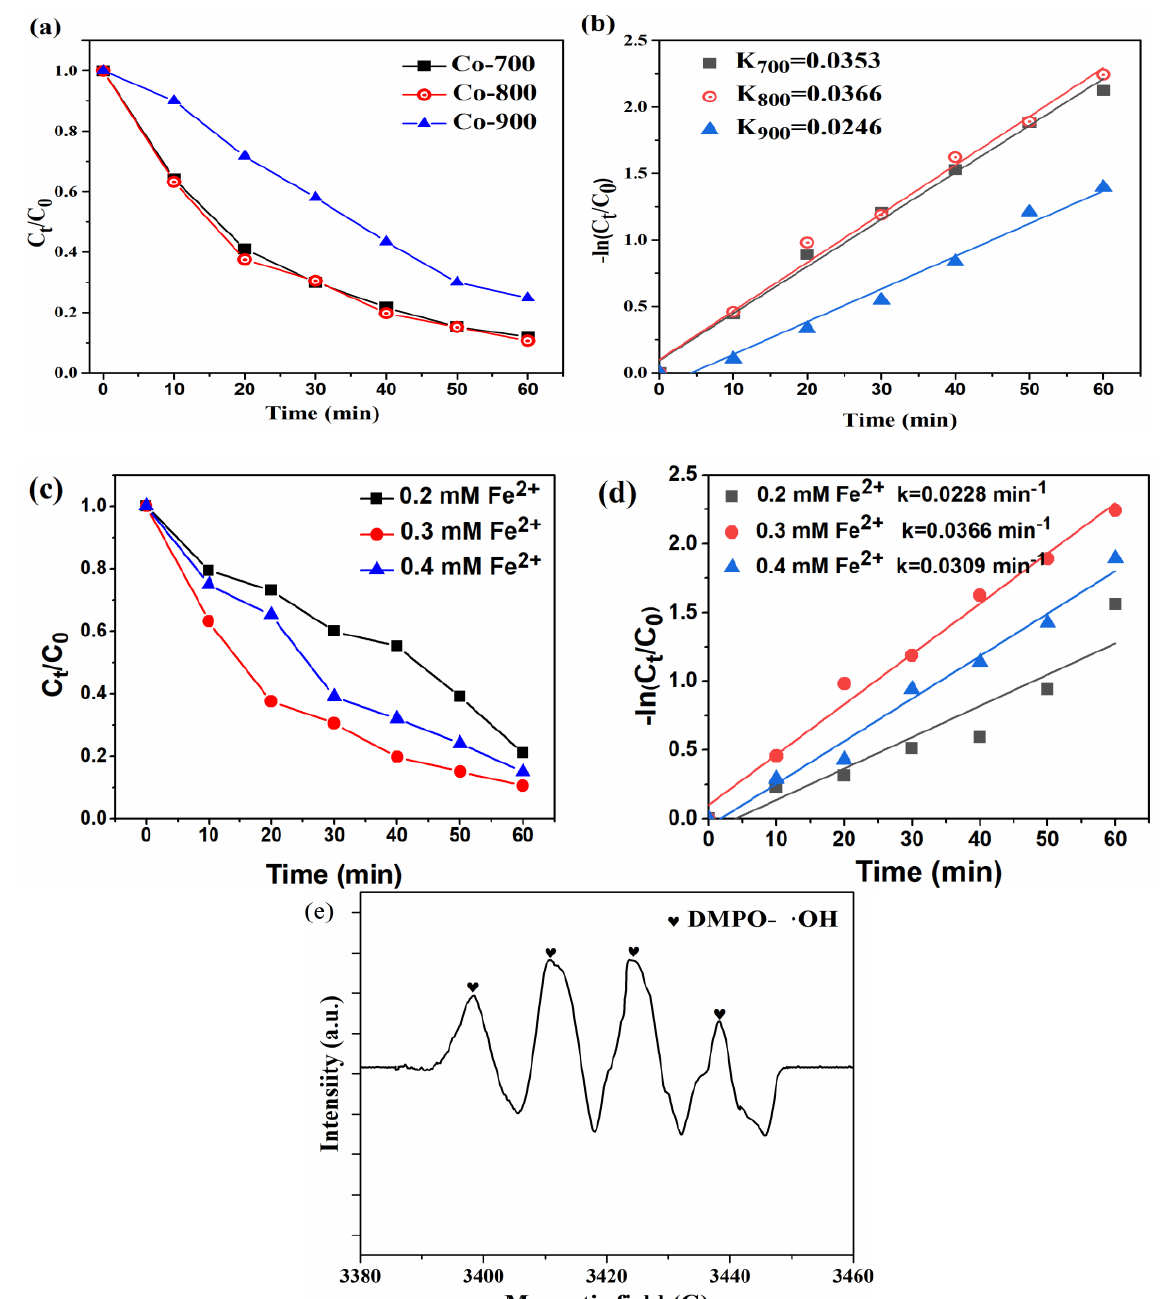
Figure 7. The E-Fenton degradation efficiency and reaction rate constants of ( a , b ) the Co-N-C synthesized at 700 °C, 800 °C and 900 °C, ( c ) and ( d ) different Fe 2+ additions; ( e ) EPR results.